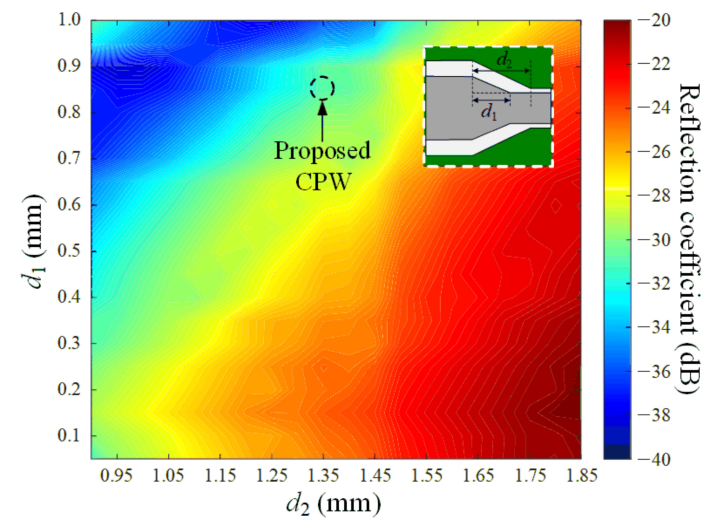
Figure 5. The reflection coefficients in accordance with d 1 and d 2 in transition part B .